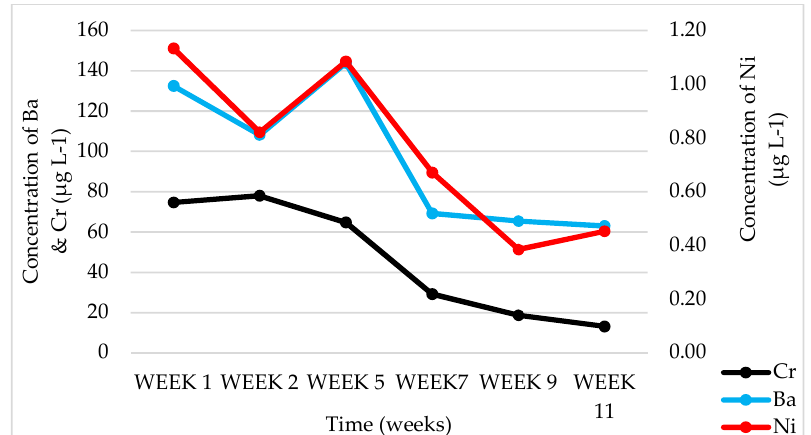
Figure 10. Chemical-element concentrations in leachates obtained from CFA (Coal-fly-ash) pots growing S. Oleracea L. for nonessential elements Cr, Ni, and Ba.